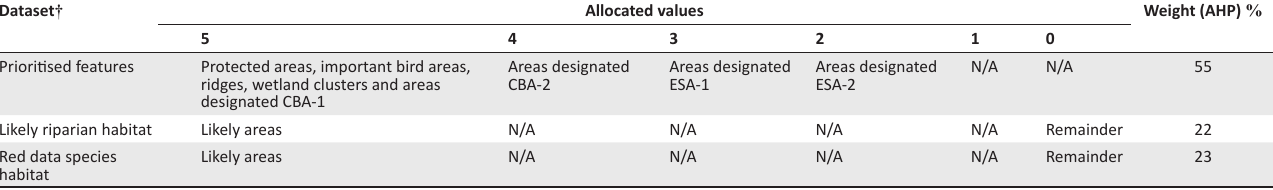
TABLE 4: Conservation priority.